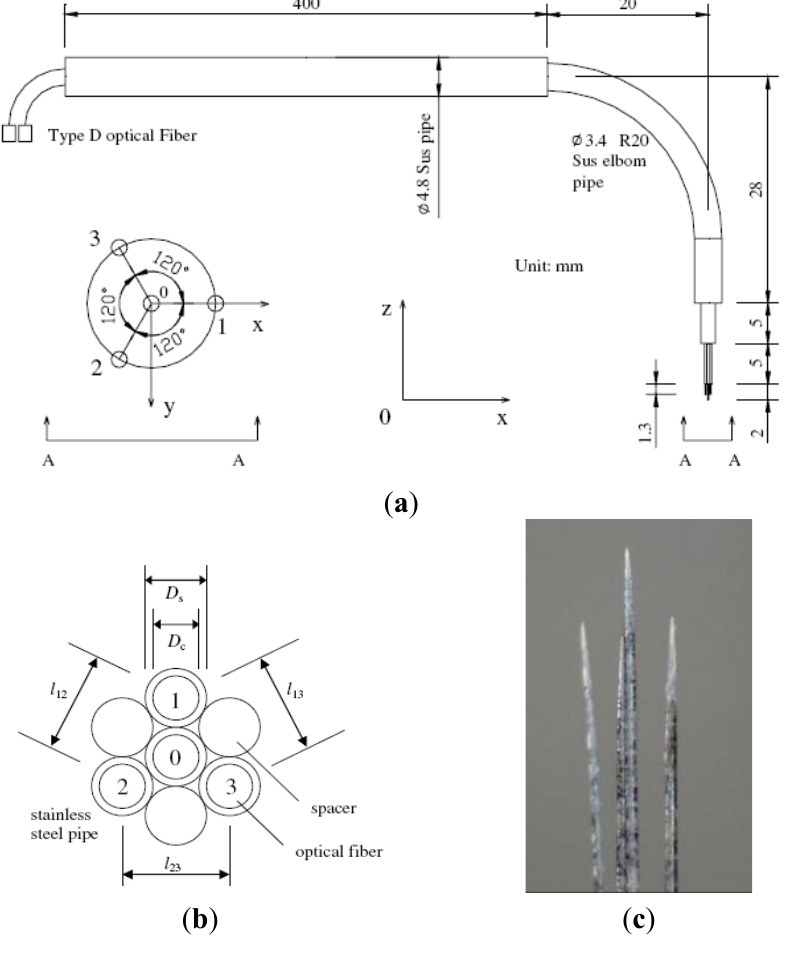
Figure 2. Design of typical optical four-sensor probes [34]: ( a ) full view of a four-sensor probe; ( b ) a hexagon module; ( c )